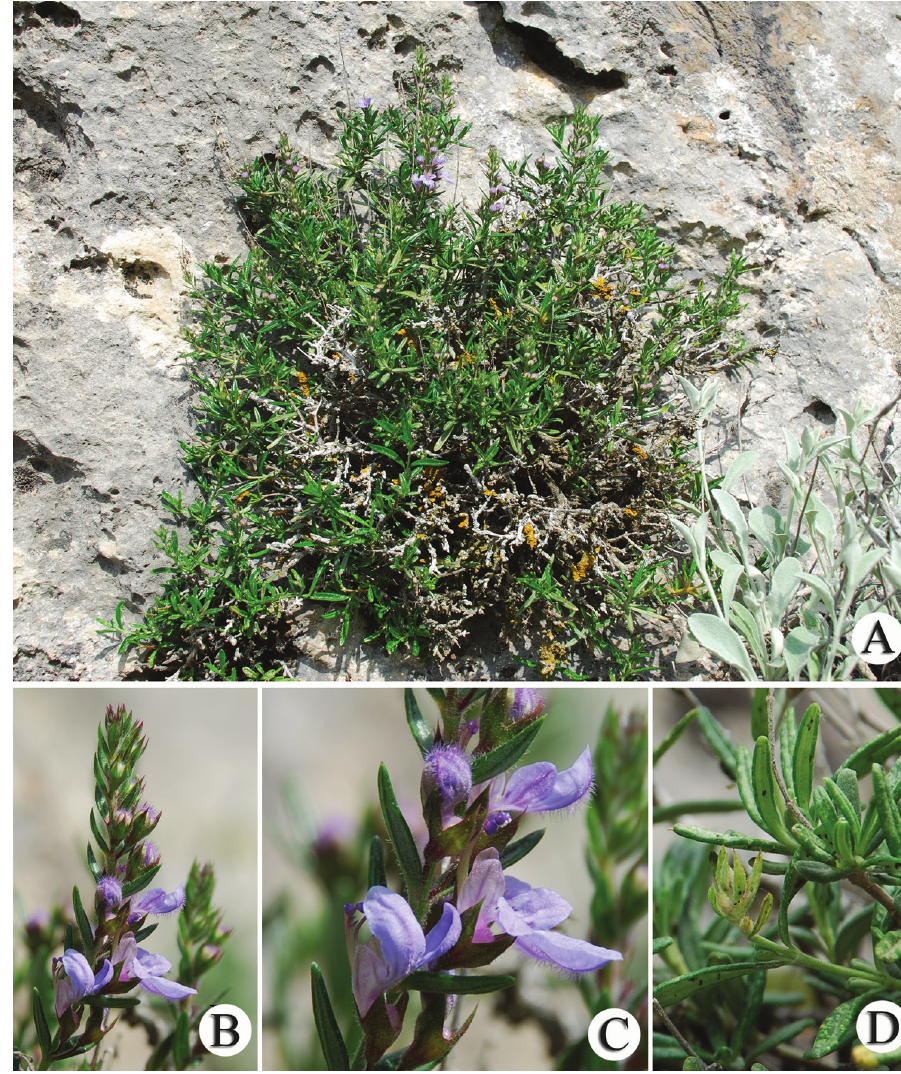
Figure 5. T. pestalozzae . A habitus B inflorescence C flower D